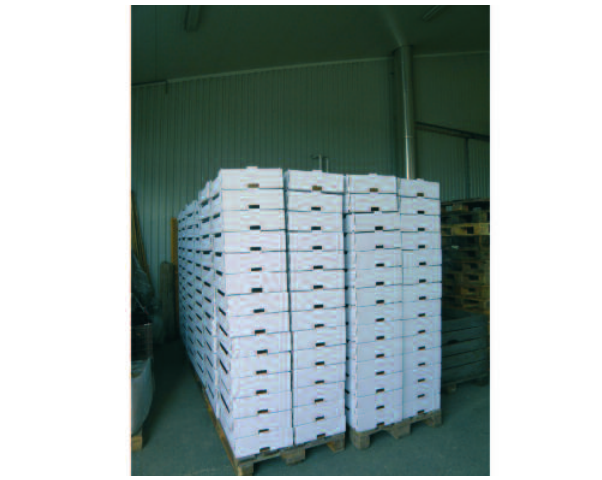
Fig. 11: Collection of the damaged fruit and those without stems Fig. 12: Paper bins for the